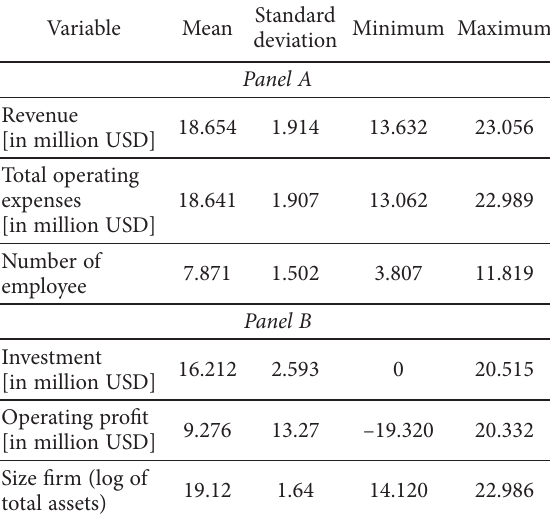
Table 1. Summary statistics of the variables